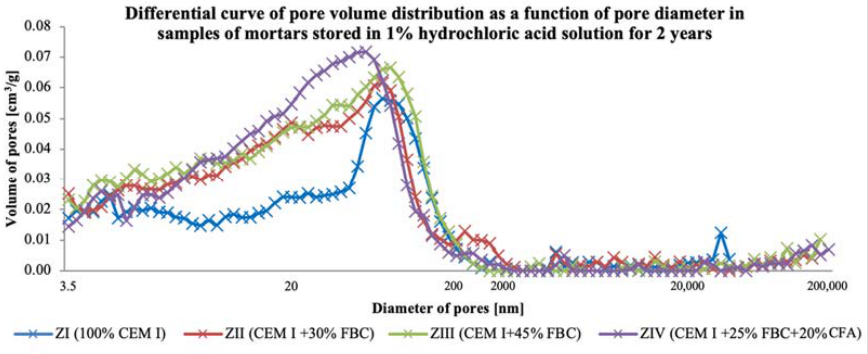
Figure 20. Differential curve of pore volume distribution as a function of pore diameter in samples of mortars stored in 1% hydrochloric acid solution for 730 days.